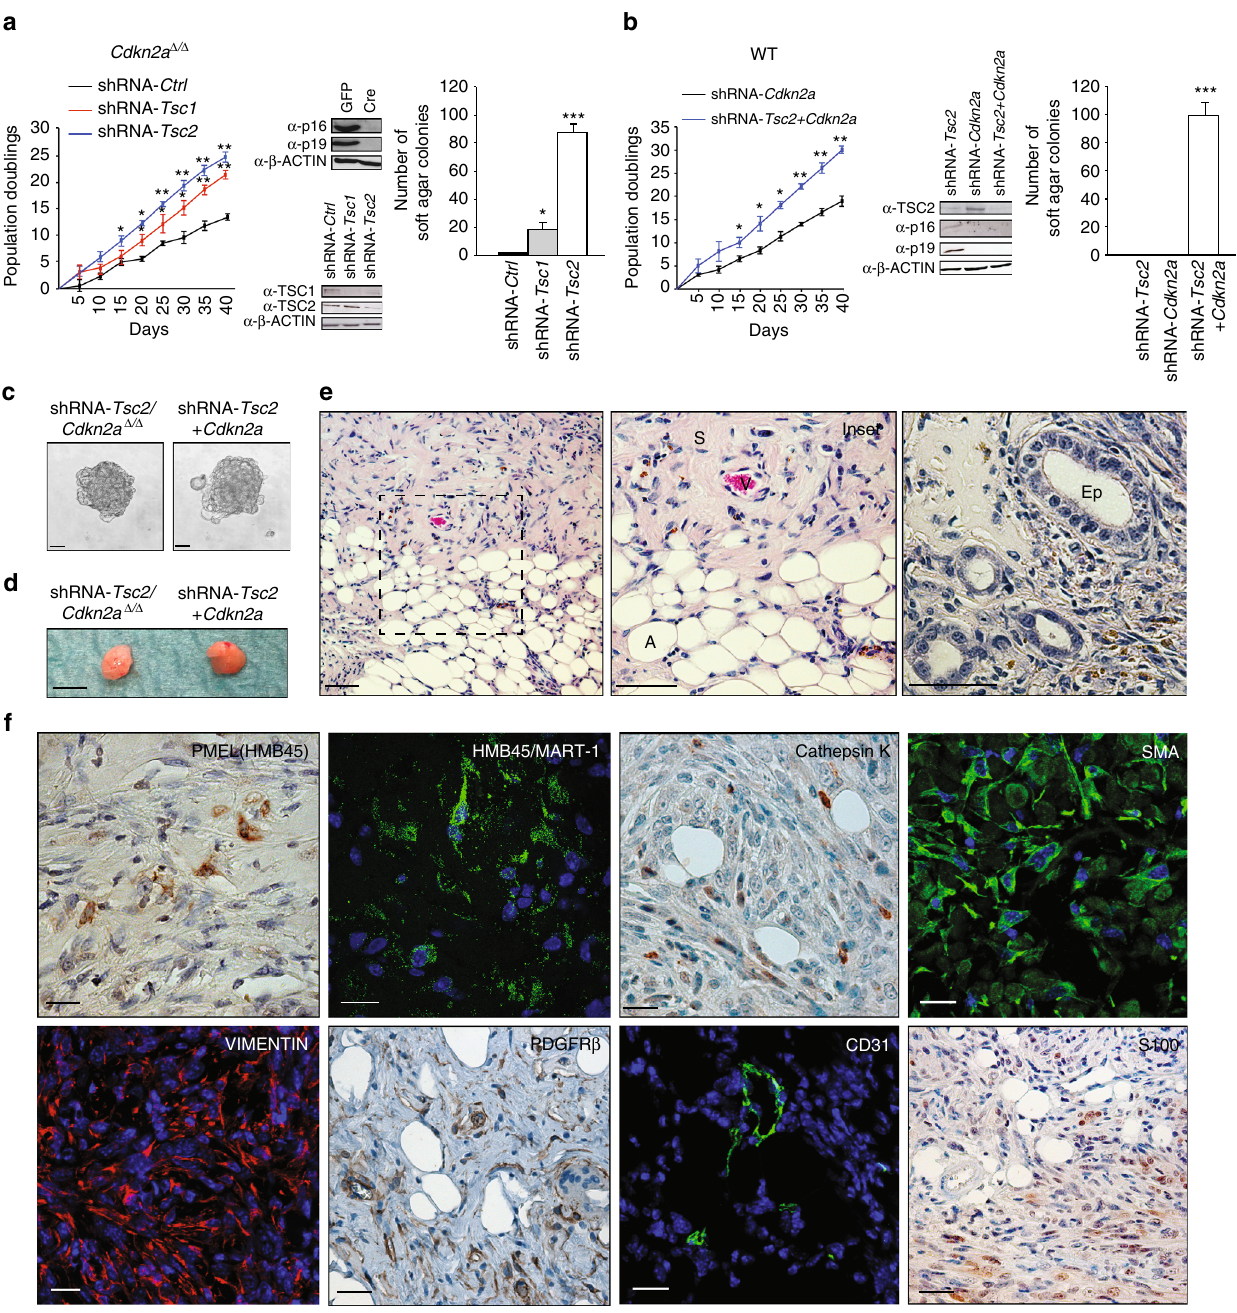
Fig. 1 An ex vivo genetically engineered model of renal AML. a Proliferation assay, western blot and soft-agar assay of Cdkn2a Δ / Δ primary kidney cells following infection with lentiviruses expressing an empty shRNA (shRNA- Ctrl ) or shRNAs against Tsc1 ( shRNA- Tsc1 ) or Tsc2 (shRNA- Tsc2 ). b Proliferation assay, western blot and soft-agar assay of primary kidney cells infected with lentiviruses expressing shRNAs against Cdkn2a (shRNA- Cdkn2a ) or Tsc2 and Cdkn2a (shRNA- Tsc2 + Cdkn2a ). All graphs depict mean ± s.d. Student ’ s t test, n = 3. ∗ P < 0.05, ∗∗ P < 0.01, ∗∗∗ P < 0.001. c Phase contrast images of spheres formed in suspension culture conditions from shRNA- Tsc2/Cdkn2a Δ / Δ and shRNA- Tsc2 + Cdkn2a primary kidney cells. Scale bars: 50 μ m. d Representative allografttumours derived from subcutaneous injections of respective sphere cells into SCID-beige mice.Scale bars: 1 cm. e Representative histology of allograft renal AML-like tumours. Characteristic histological features of AML are indicated by letters, where A shows adipocyte, S shows spindle cells and V shows an aberrant blood vessel. Epithelial structures are indicated by Ep. Scale bars: 50 μ m. f Positive immuno fl uorescence or immunohistochemical staining in engineered renal AML-like allograft tumours for PMEL(HMB45), HMB45/MART-1, CATHEPSIN K, SMA, VIMENTIN, PDGFR β , CD31 and S100. Scale bars: 50 μ